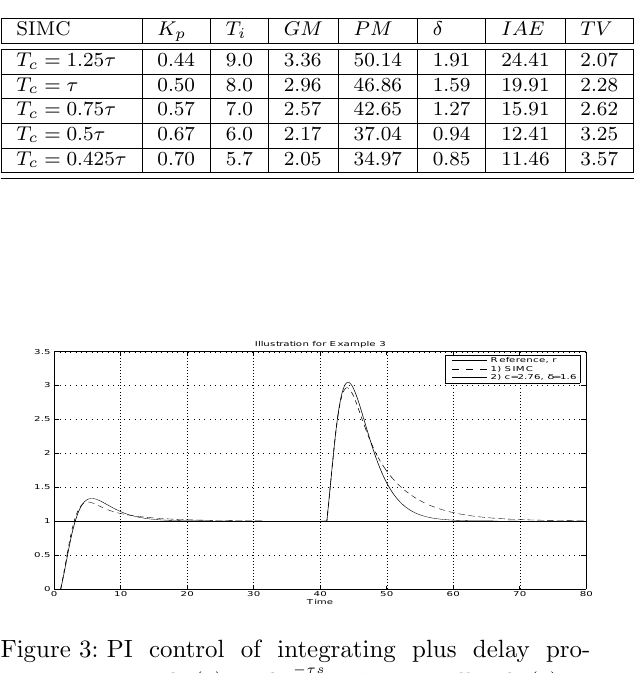
Figure 3: PI control of integrating plus delay pro- cess, h p ( s ) = k e − τs . PI-controller h c ( s ) = s K p 1+ T i s with settings as in Table T i s